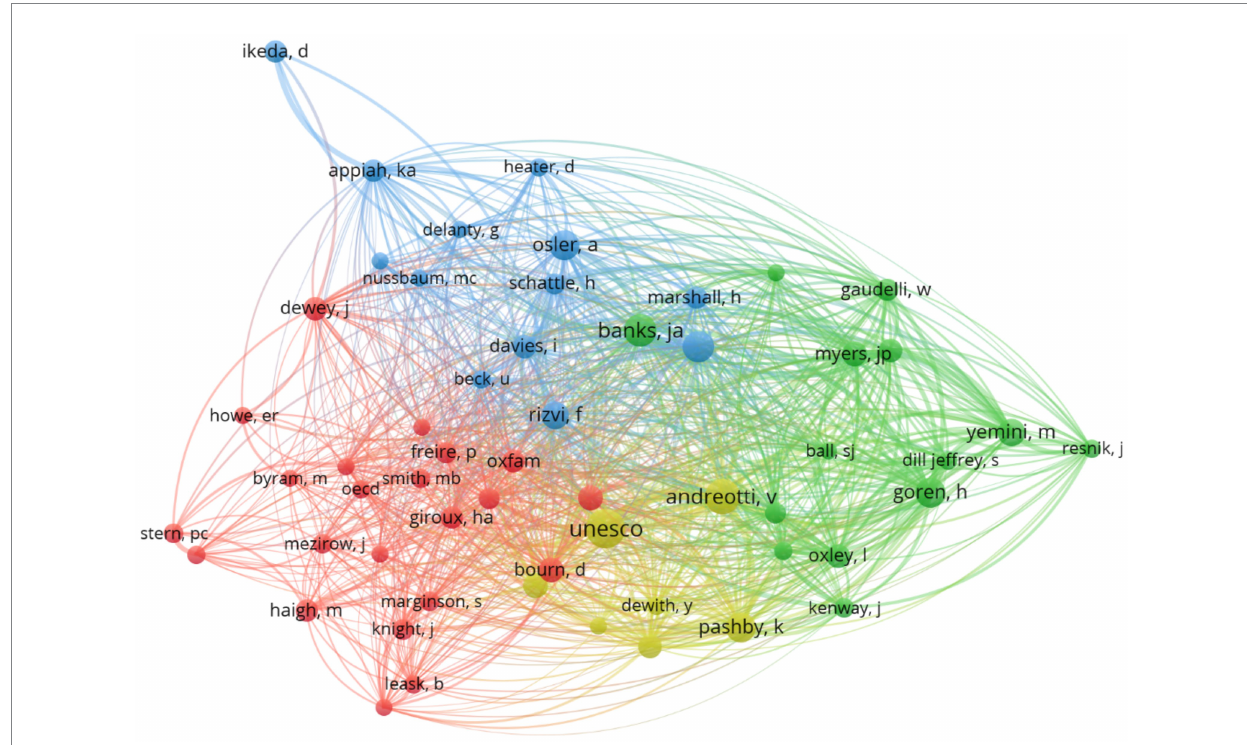
FIGURE 4 Author co-citation analysis (threshold 20 citations, display 56